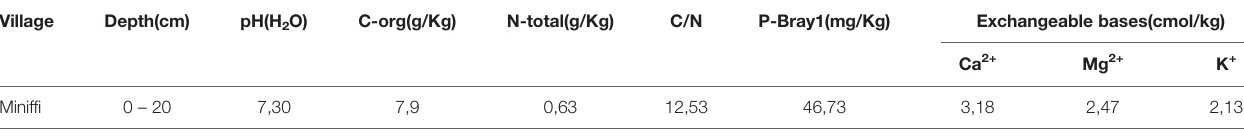
TABLE 1 | Chemical characteristics of the soil of experimental